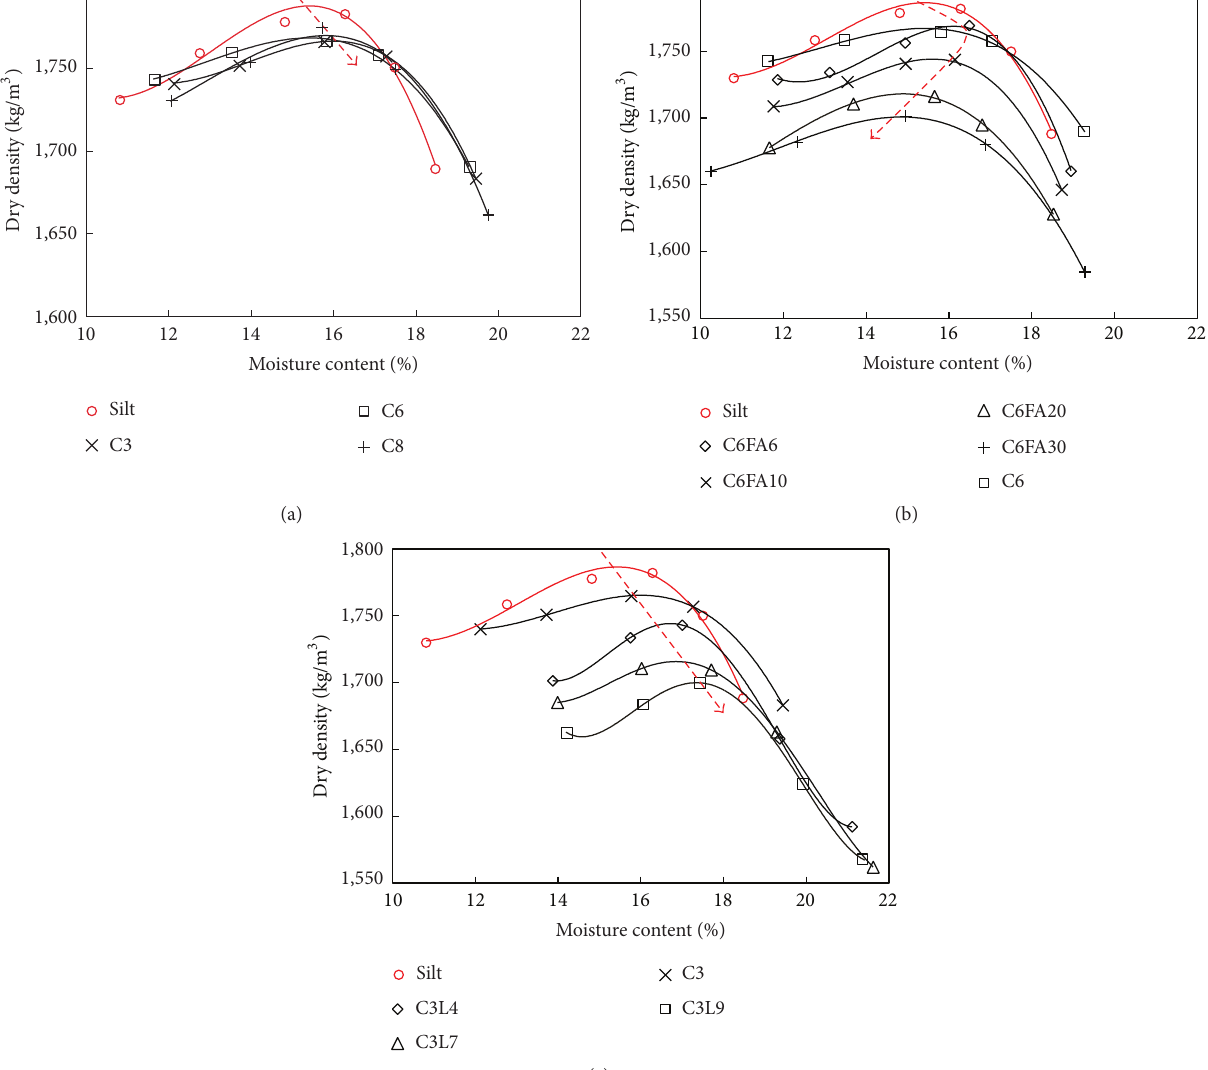
used. The cement-treated samples (C3, C6, and C8) show UC strength increase linearly proportional to the increase of the cement content. The values fall in the ranges of 0.59 MPa to 1.48 MPa at 7 days and 0.68 MPa to 1.67 MPa at 28 days. This implies that moderate strength increases (14.2% on average) are gained from 7 days to 28 days, if the sample cement content remains the same. The strength develops due to the cement hydration creating a matrix of gel (i.e., the ettringite) to solidify the soil particles; and the gel grows over